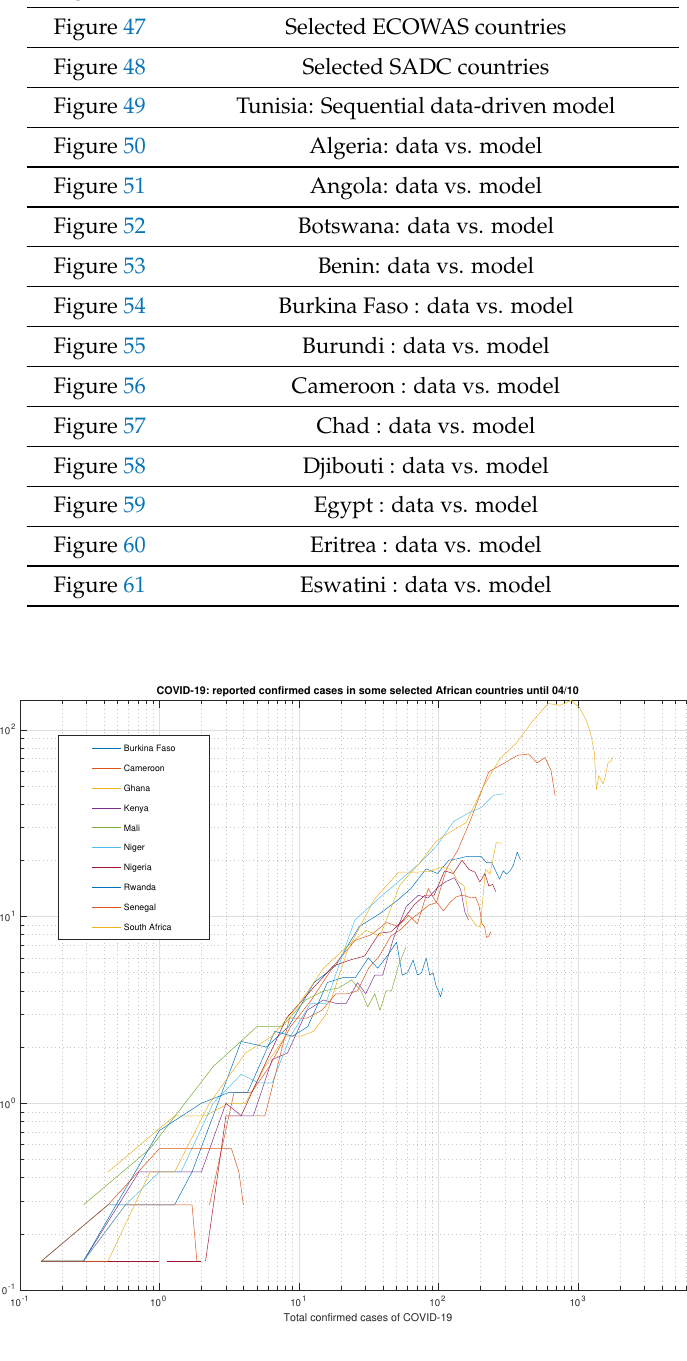
Figure 45. Covid-19 samples in selected countries in